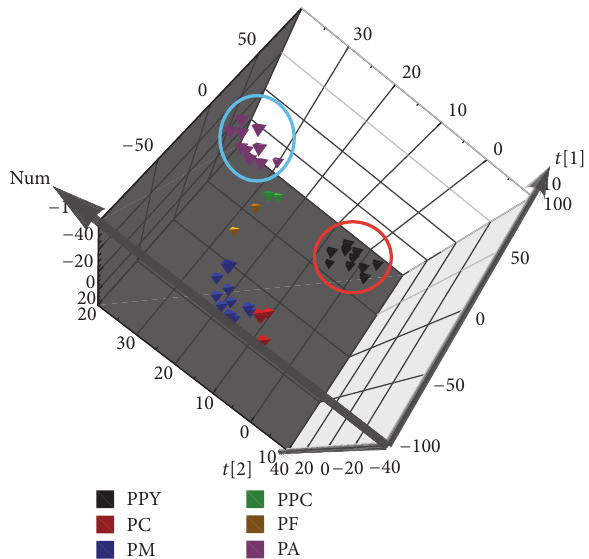
Figure 5: Three-dimensional score plot of partial least squares discriminant analysis for UHPLC fingerprint.